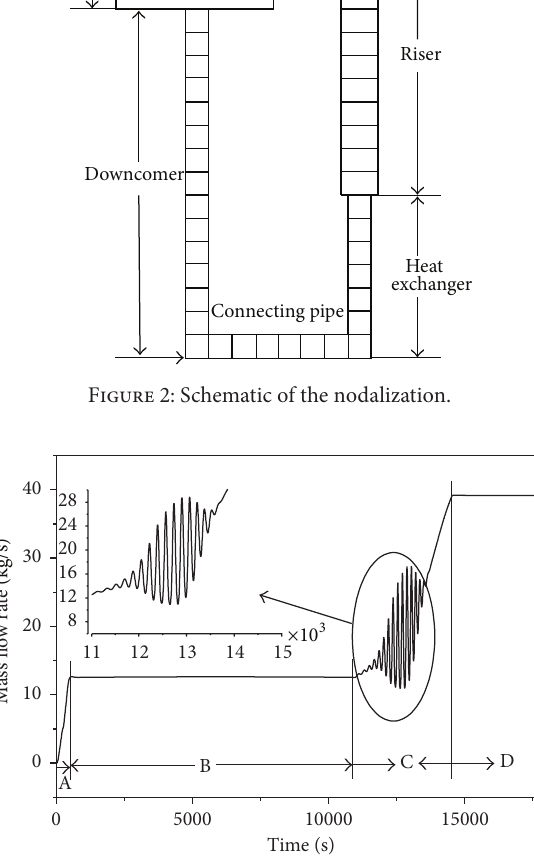
inside the containment steps from the same value as that inside water tank to some value and remains